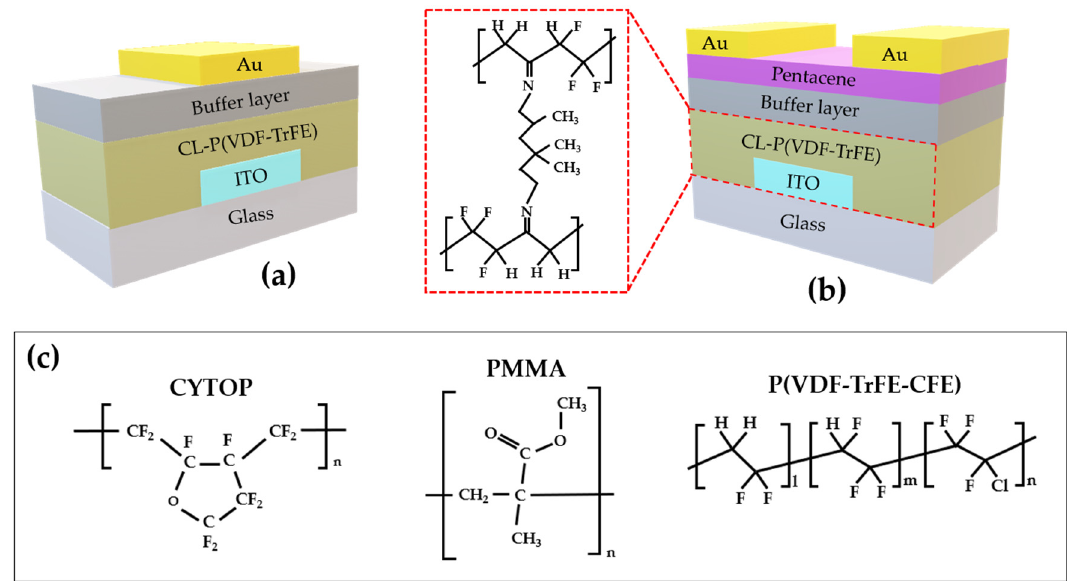
Figure 1. ( a ) Capacitor and ( b ) transistor structure with a B/F bilayer. ( c ) The chemical structure of the buffer layers: CYTOP, PMMA, and P(VDF-TrFE-CFE). Table 1. Capacitance, thickness, and the dielectric constant for the ferroelectric and buffer layers.